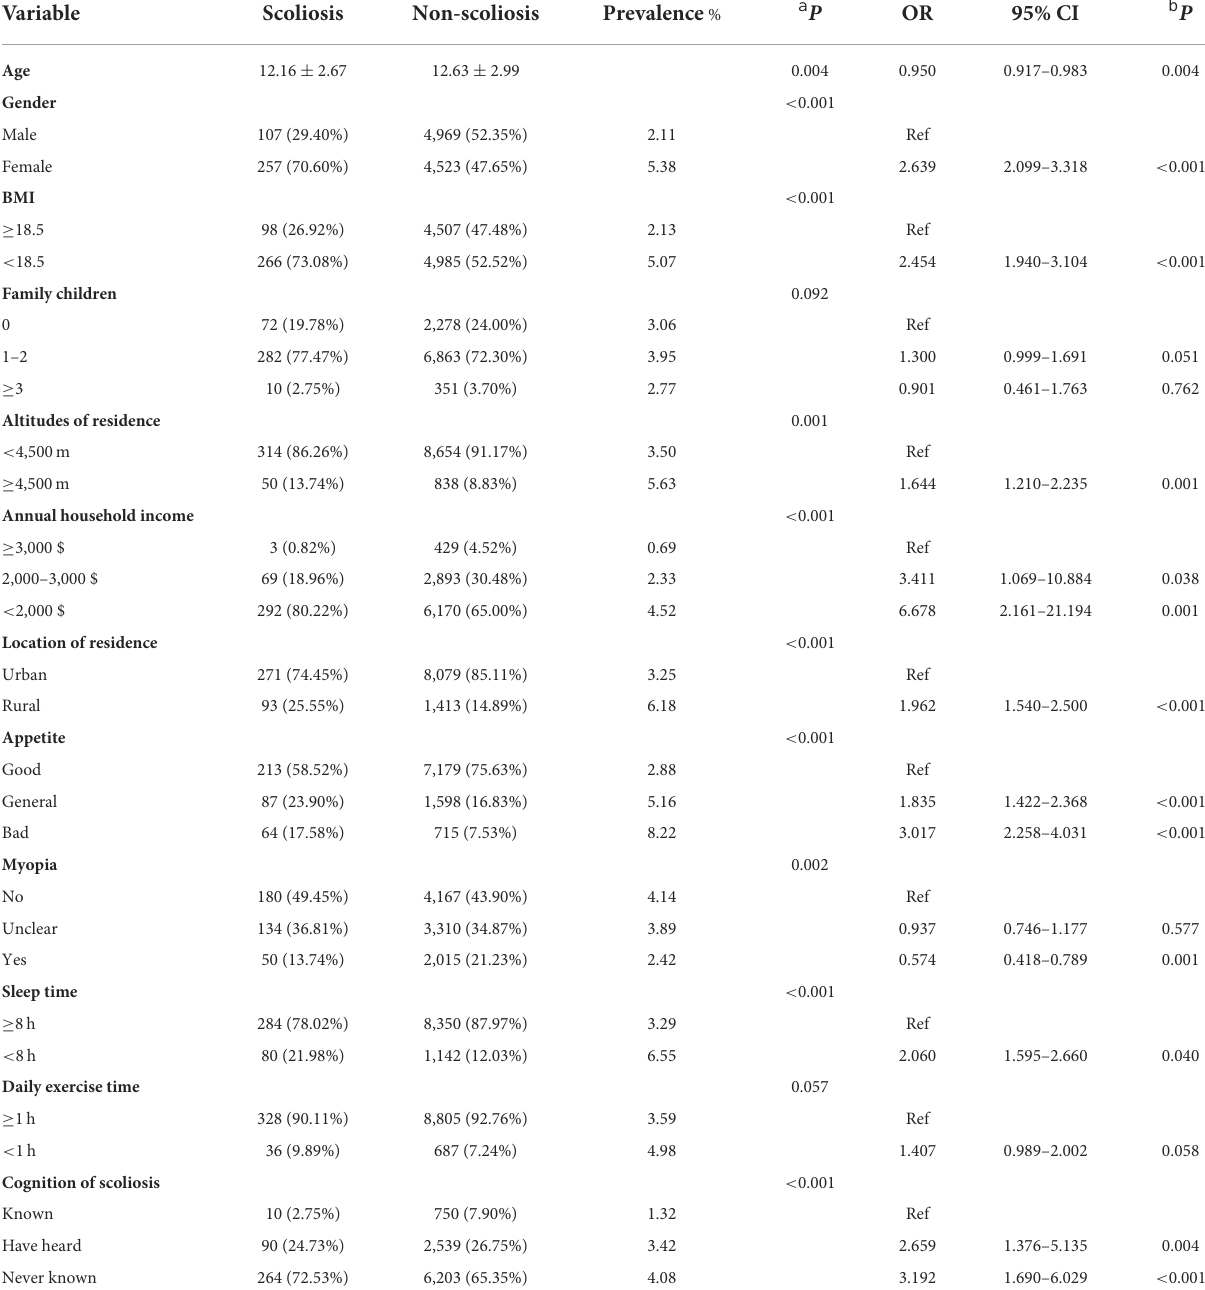
TABLE 2 Demographic characteristics of participants and associated factors with scoliosis by univariate logistic regression analysis. Variable Scoliosis Non-scoliosis Prevalence %